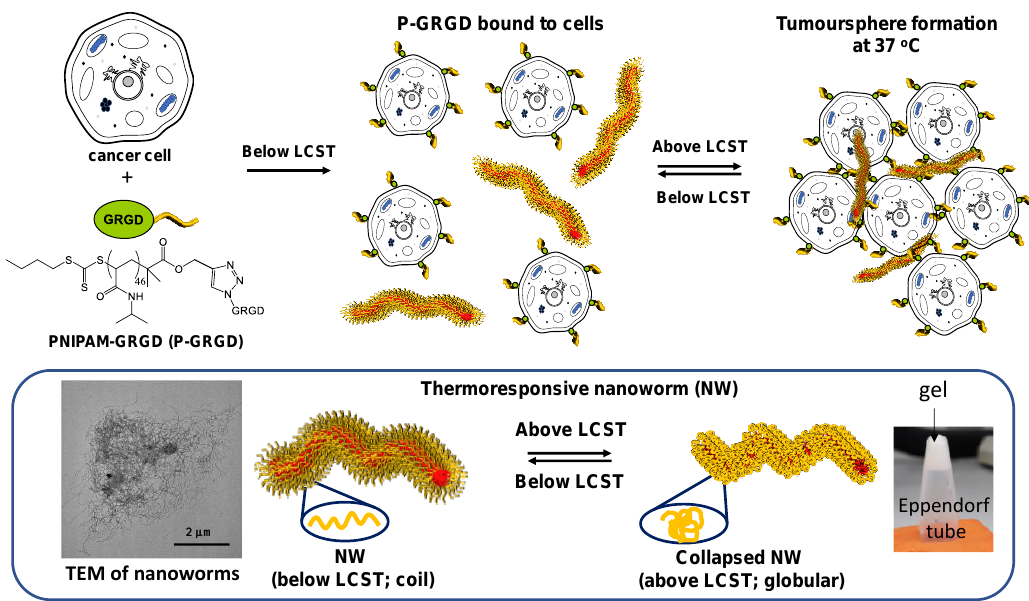
Figure 1. Schematic illustration how the RGD polymeric matrix work. PNIPAM-GRGD (P-GRGD) below LCST binds to the cancer cell surface, and after the addition of nanoworms (NWs), aids in the formation of cancer cell spheres. This process promotes the stemness and proliferation required for stem cell development. Lowering the temperature below the LCST allows for the dissociation of cells to be used in next generation cultures. The right picture of the bottom panel is the TEM image of nanoworm, and the left one is the gel image of the